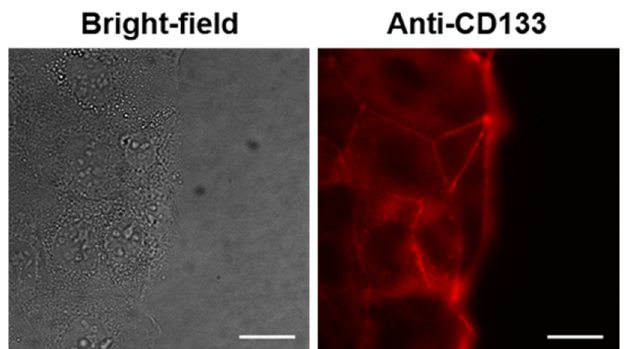
Figure 9. Fluorescence microscopy images of human cells derived from colorectal carcinoma (CaCo-2) stained with anti-CD133 antibody conjugated to Atto 565 for 30 min. Left—a bright-field image of the cells. Right—fluorescence emission of cells stained with anti-CD133-Atto 565. The scale bars correspond to 20 µm.